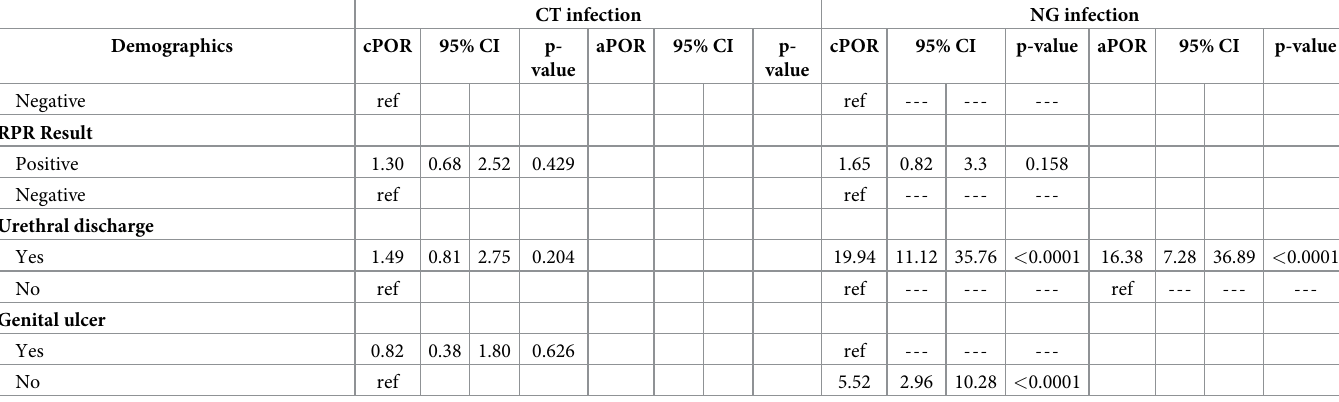
19% of RPR+ and 4% of RPR- men and conversely 20% of men with ulcers were RPR+ com- pared to 4% of men without ulcers (p < 0.001). Among HIV+ men, none of the seven who were RPR+ had reported and/or observed ulcers while 23% of 43 HIV+ RPR- men had ulcers (p = 0.319). In contrast, among HIV- RPR+ men 21% had reported or observed ulcers com- pared to only 4% of HIV-RPR- men (p < 0.001). This suggests that ulcers among HIV+ men were more likely herpetic while among HIV- men at least one fifth were syphilitic. Although HIV- men were more likely to be circumcised than HIV+ men (67% vs . 58%) in our program, this difference was not significant (p = 0.196). Among circumcised men, those who were HIV+ were more likely to have ulcers (13% vs . 4%, p = 0.074) and to be RPR+ (20% vs . 4%, p = 0.003). Among uncircumcised men, those who were HIV+ were also more likely to have ulcers (27% vs . 7%, p = 0.001) while the difference in RPR+ results was not significant (12% vs . 6%, p = 0.324).